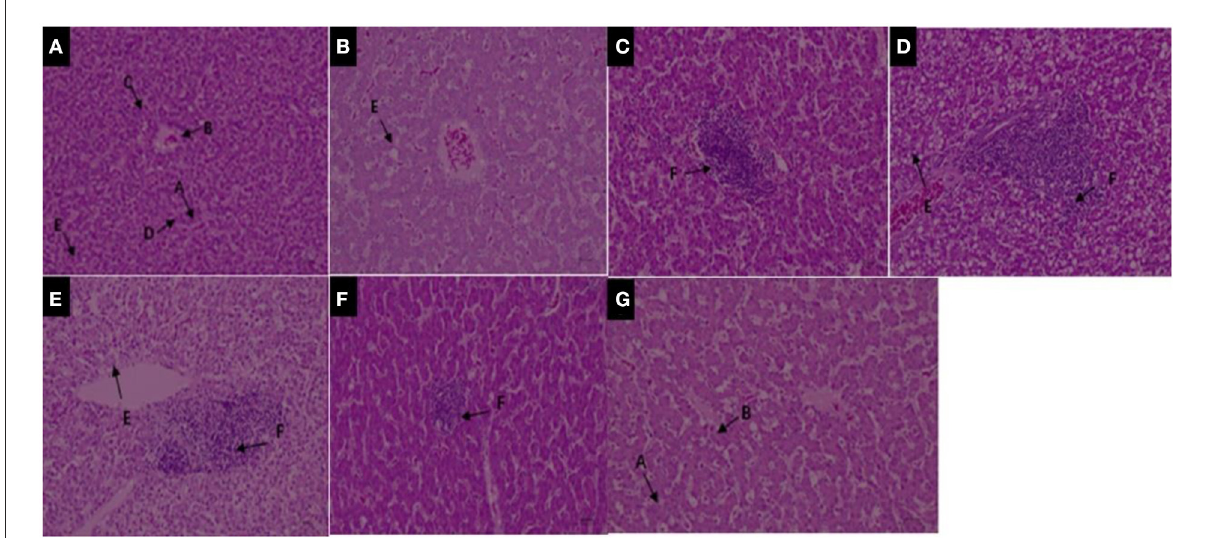
FIGURE2 (A–D) Liver structure under 200 × magnification during deltamethrin treatment for 0 (A) , the 1st (B) , 7th (C) , and 14th day (D) . (E–G) Liver structure under 200 × magnification at the 1st (E) , 7th (F) , and 14th day (G) during deltamethrin treatment withdrawal. A, Hepatic sinusoidal lacunae; B, hepatic veins; C, hepatocytes (cords); D, bile ducts; E, lipid droplet enrichment; F, local lymphocytic infiltration.